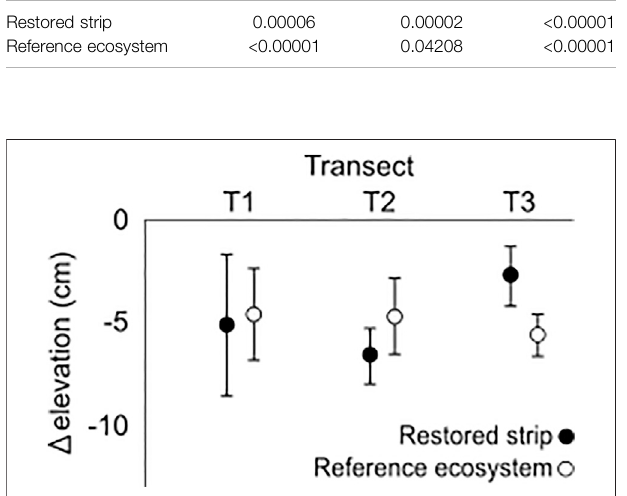
FIGURE 4 | Mean elevation differences ( ± CI 95% ) 1 and 3 years post- restoration on the three transects [subsampling per transect: restored strip, n (cid:2) 13;referenceecosystem(undisturbedpeatlandcontiguoustotherestored strip), n (cid:2) 22].